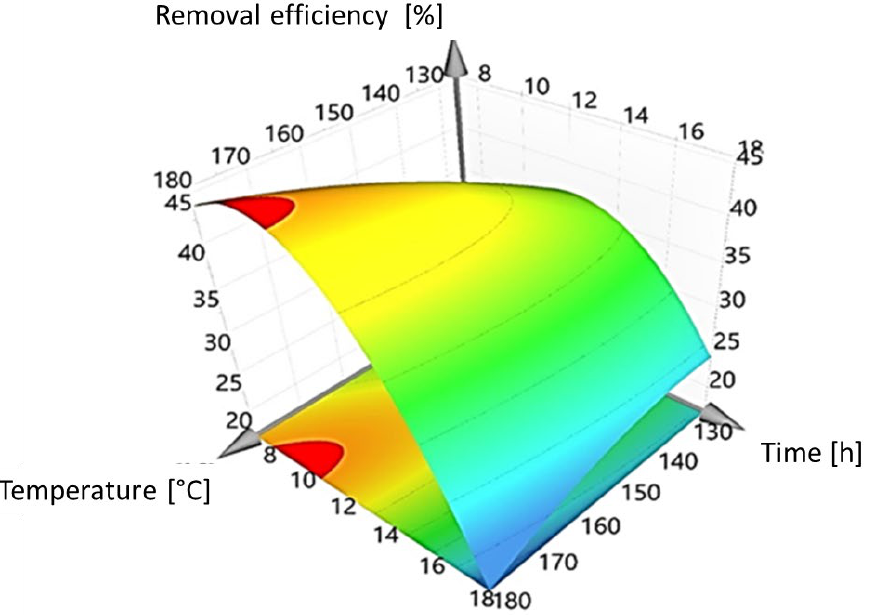
Figure 4. Three-dimensional response surface for the photocatalytic activity of synthesized BiOI/mordenite composites expressed as removal efficiency of caffeic acid under different synthesis conditions of temperature and